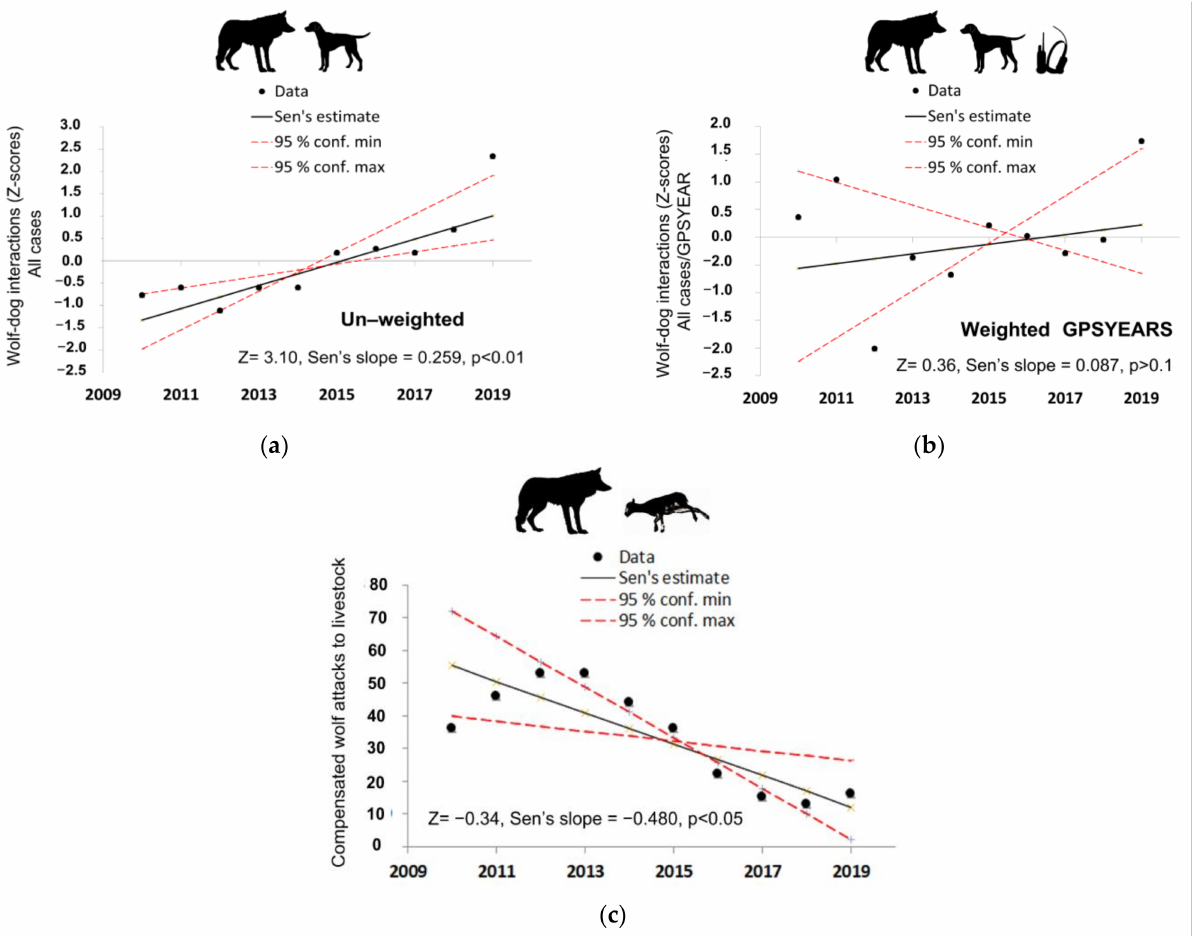
Figure 3. Trends for the unweighted ( a ) and weighted ( b ) with dog-GPS use (GPSYEARS) wolf–hunting dog interactions for the “all cases” verification class, and ( c ) trends of confirmed wolf attacks on livestock in the study